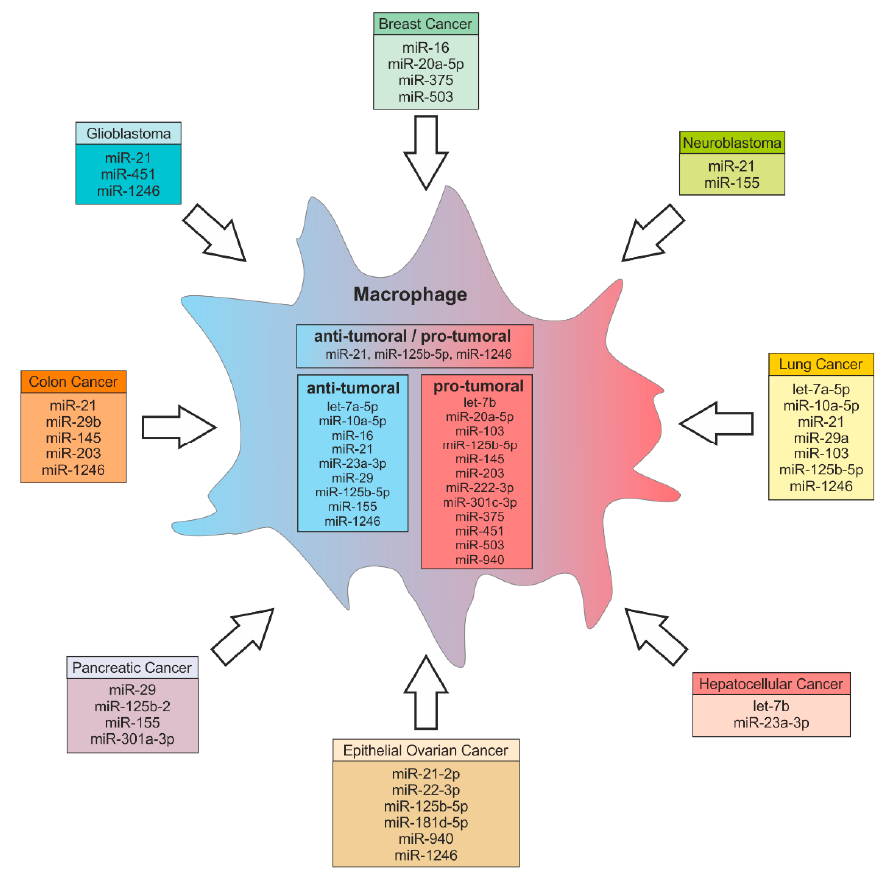
Figure 2. Tumor-derived miRs and their potential functions in macrophages. MiRs can be